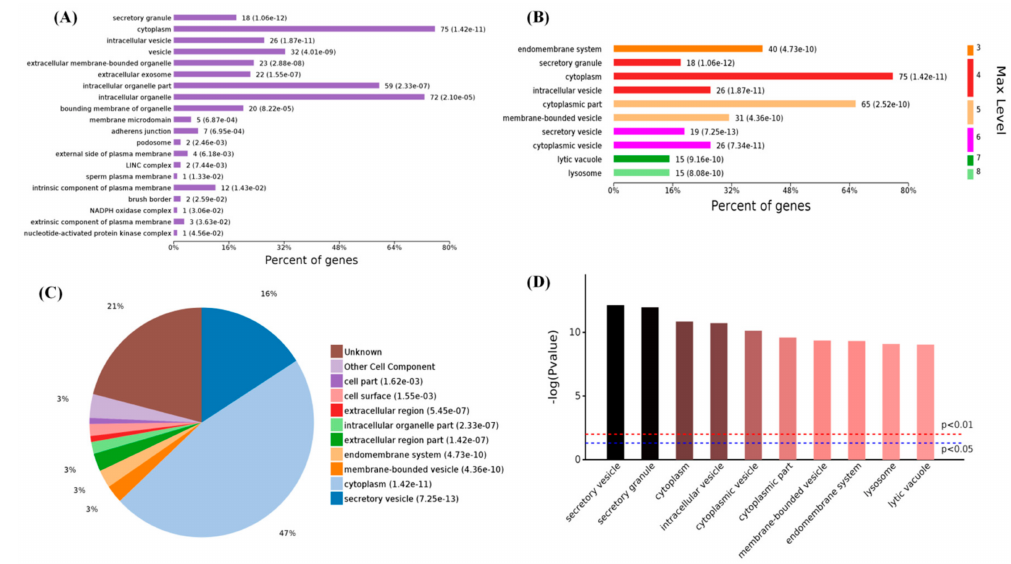
Figure 4. Enriched cell components of 119 differential proteins in high-melatonin groups. ( A ) Levels of enriched cell components; ( B ) significantly enriched cell components (top 10); ( C ) expressed proteins of enriched cell components; ( D ) significantly enriched cell components with p -values.